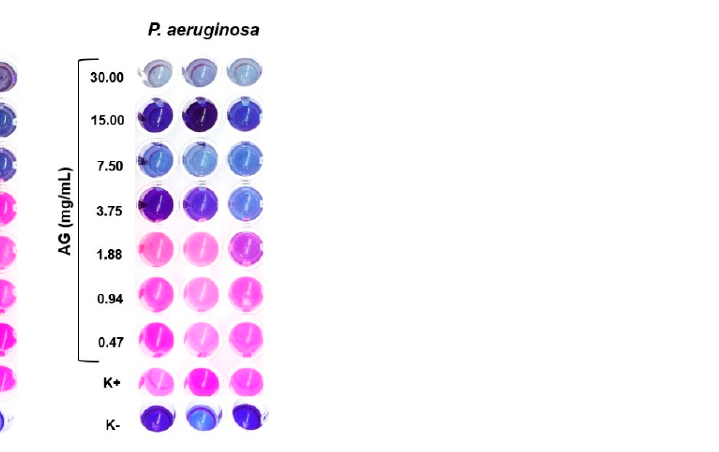
Figure 1. Determination of the minimum inhibitory concentration (MIC) against Staphylococcus aureus ( S. aureus ) and Pseudomonas aeruginosa ( P. aeruginosa ) by resazurin-based 96-well plate microdilution method.